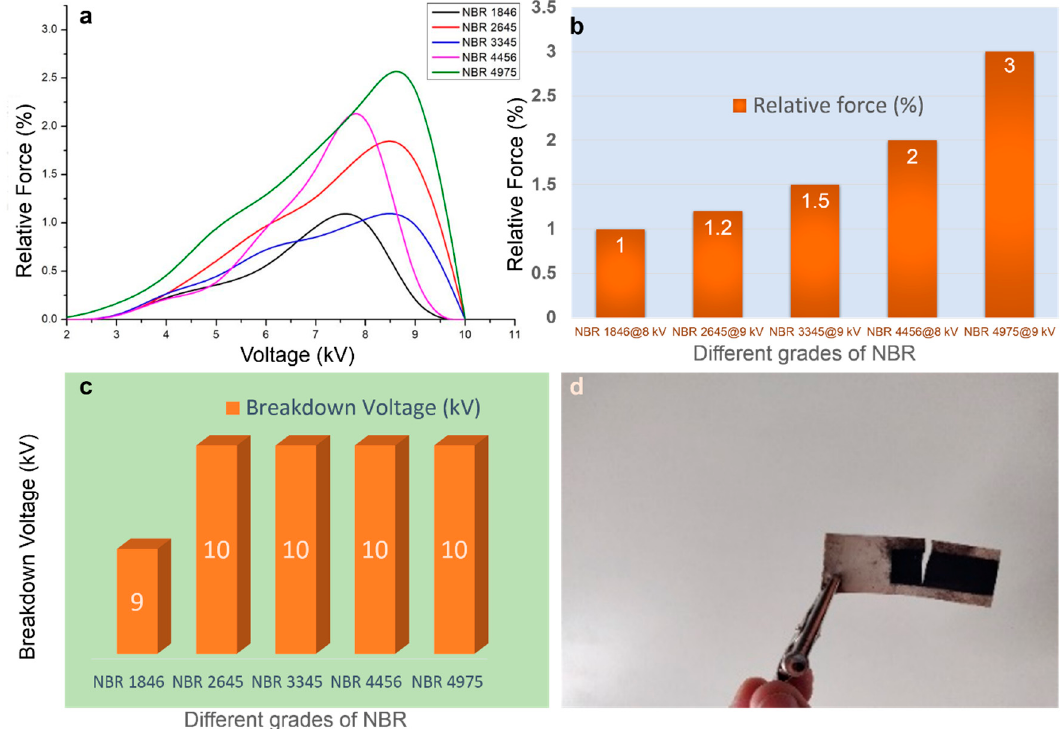
Figure 3. Effect of ACN content on actuation performance of NBR composites: ( a ) relative force (%) for various NBR grades as a function of voltage, ( b ) maximum actuation for different grades of NBR substrates; ( c ) breakdown voltages of different NBR grades, and ( d ) photograph of sample after testing.